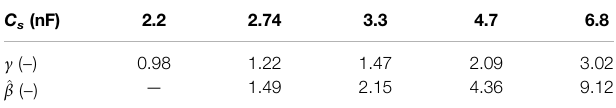
TABLE 3 | Values of storage capacitors available for the experiments, and corresponding values of parameter γ , and ^ β (i.e., the capacitance swing for which this storage capacitor is